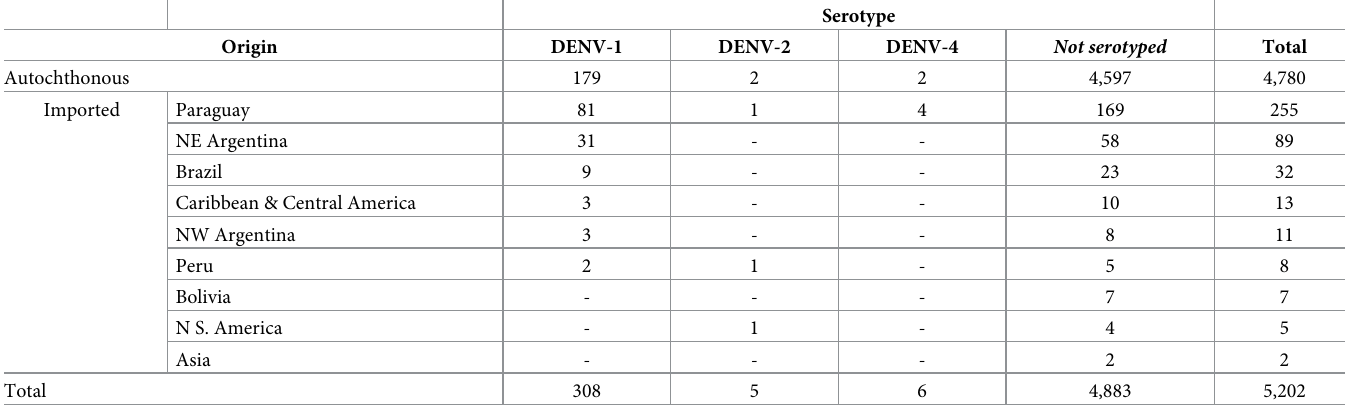
Table 2. Number of dengue cases in Buenos Aires according to serotype and likely origin of